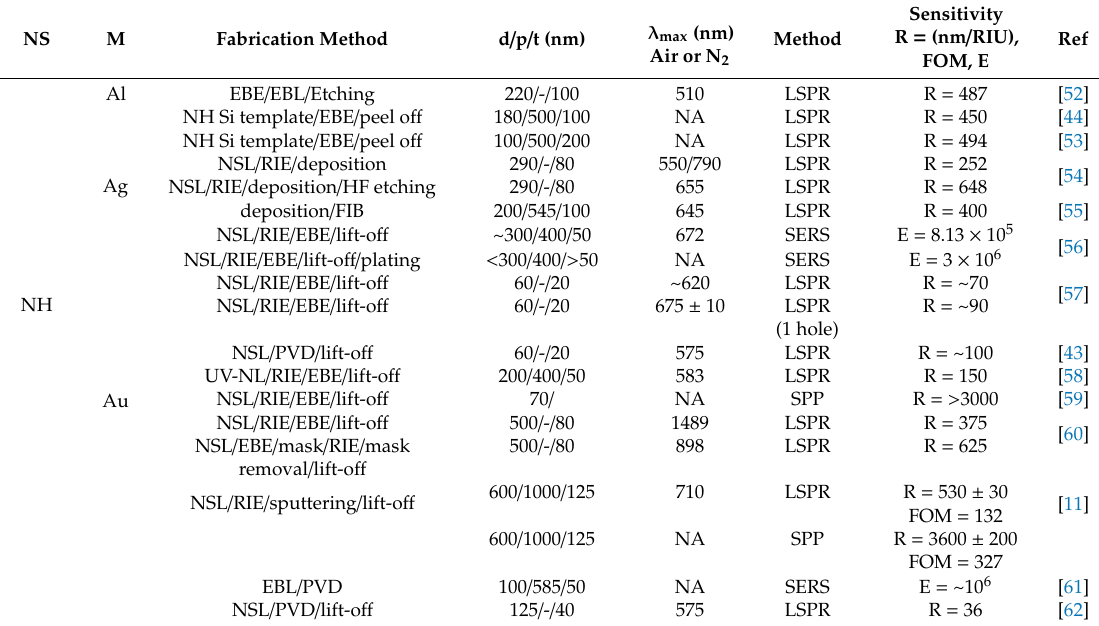
Table 1. Sensitivity of plasmonic-active nanostructured thin